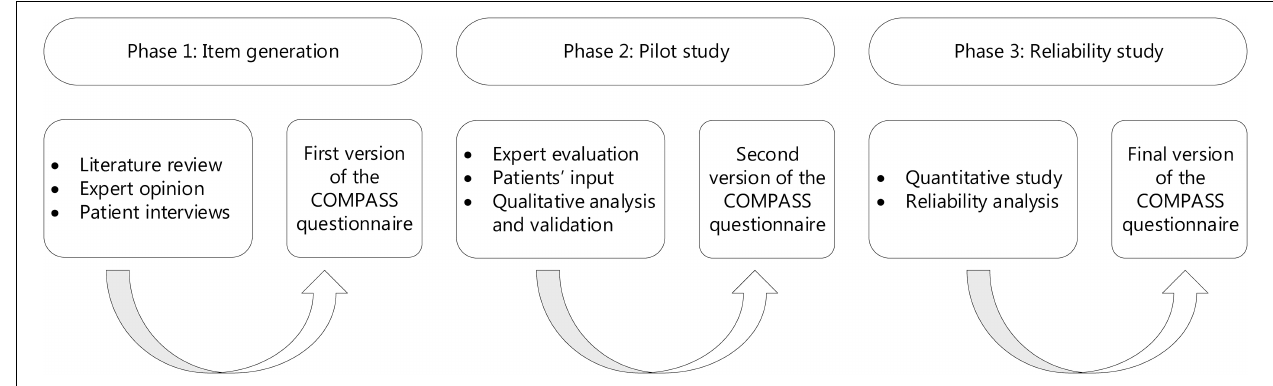
FIGURE 1 | The three phase procedure for development and validation of the COMPASS